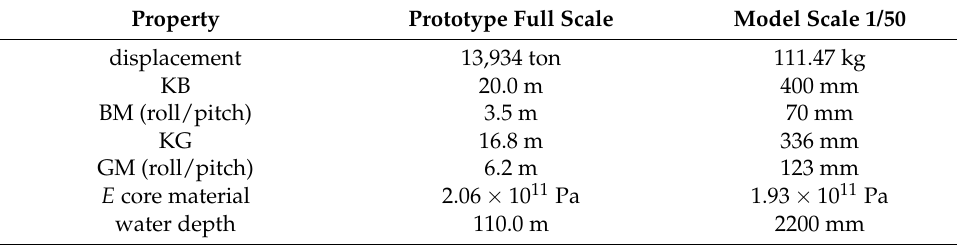
Table 3. Main properties of the floater.